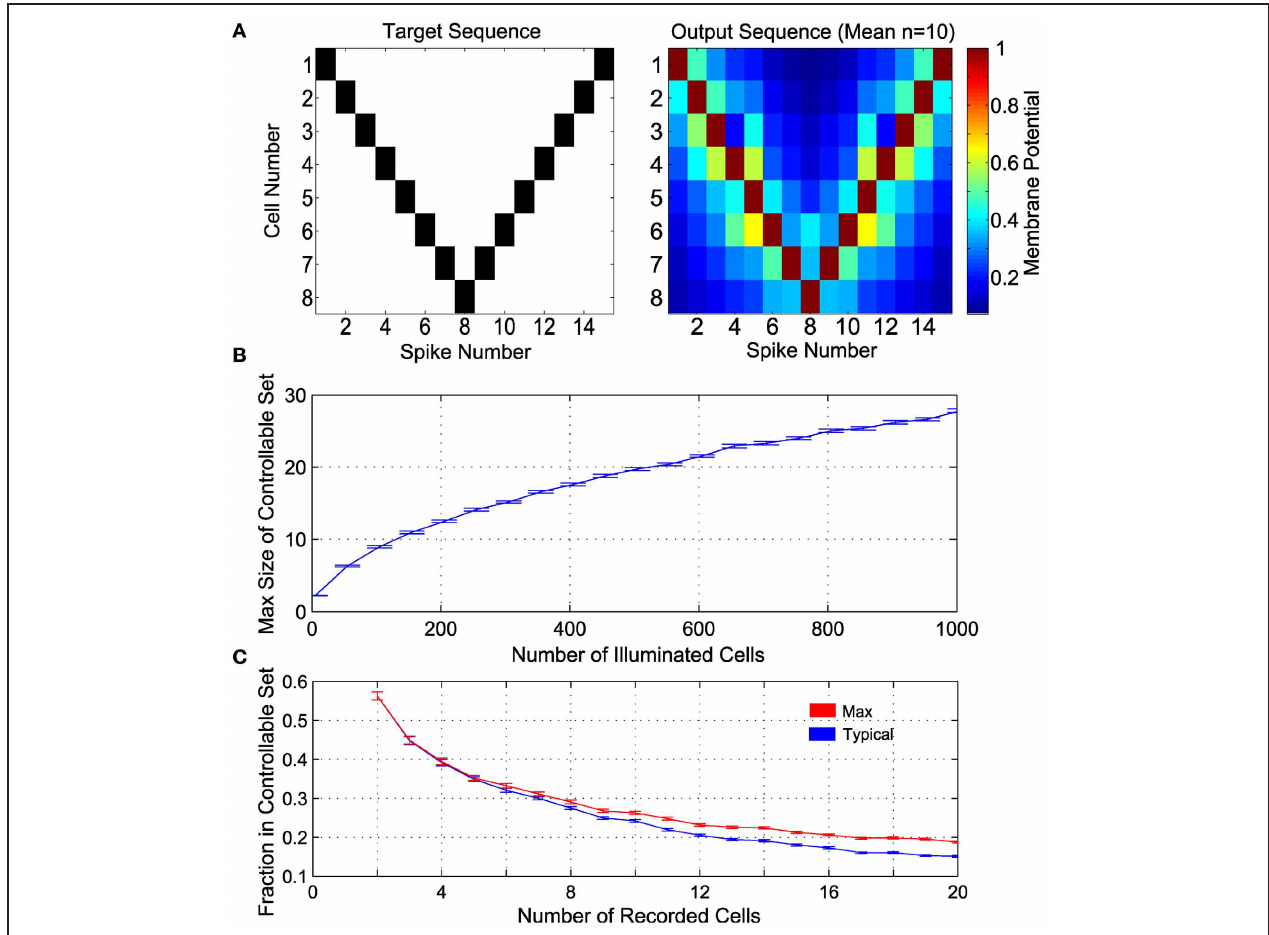
within a random subsample of “recorded” cells (e.g., near an electrode), given by the size of the largest subset satisfying the monotonicity criterion. In addition, a realization of a convex subset is found; this is the Typical fraction of controllable cells. In panels (B) and (C) , α is lognormal distributed with mean 1 and variance 0 . 25, β is exponentially distributed with mean 1, n = 100 realizations are sampled at each size, with results plotted as mean ± standard